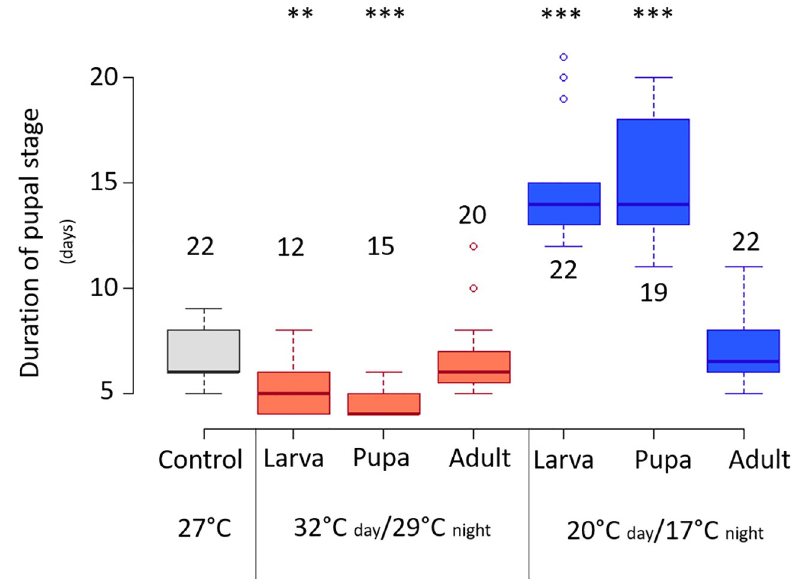
Fig 5. Duration of male E . suzannae pupal stage (in days) at different temperatures. Color of bars denotes temperature range (grey = 27˚C, red = 32–29˚C, blue = 20–17˚C). Treatments are also separated by the stage at which temperature exposure began. Asterisks denote significant differences compared to the duration of the pupal stage at 27˚C. Numbers above plots denotes replicates. N = 12–22 male wasps.